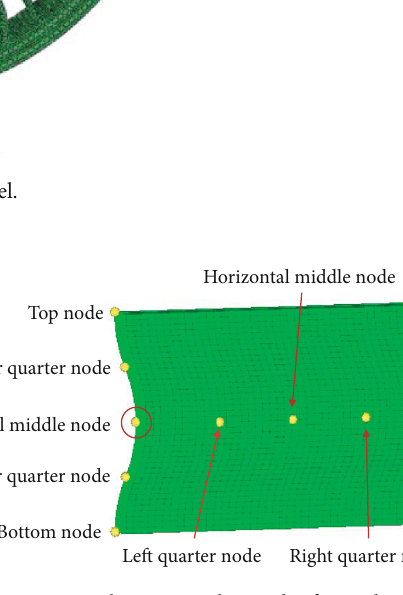
Figure 9: Vibration marker nodes for